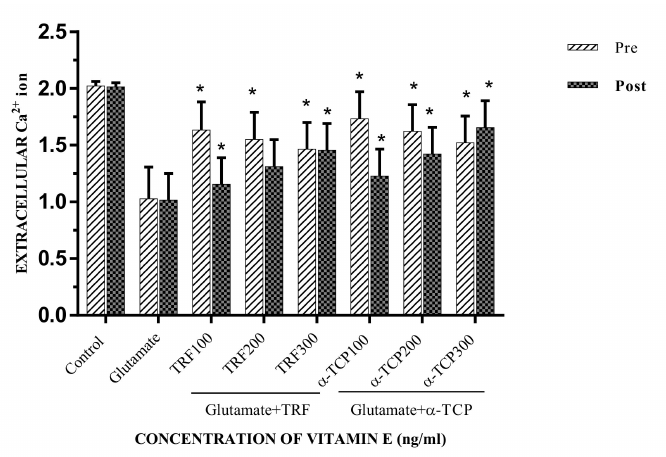
Figure 8. Pre- and post-treatment of TRF and α -TCP against glutamate-injured astrocytes in extracellular Ca 2+ ions. Data represent the mean ± SEM of three independent experiments ( n = 3 in each experiment). * p < 0.05, TRF- and α -TCP-treated groups compared with the glutamate-treated group. This shows that TRF and α -TCP, at a low concentration (100 ng) in pre-incubation, increased the levels of extracellular Ca 2+ ions, while a high concentration of TRF and α -TCP (300 ng) in post-incubation decreased the level of extracellular Ca 2+ ions against the toxicity of glutamate in primary